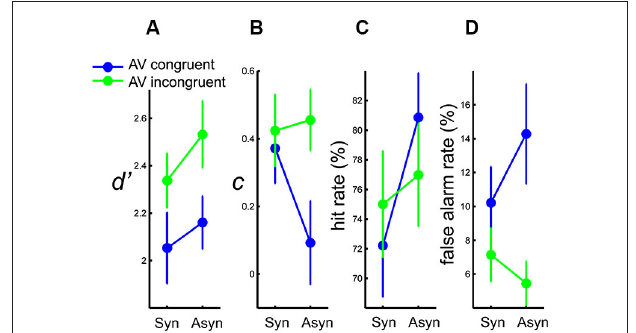
FIGURE 3 | Results of (A) mean d’ , (B) mean c , (C) mean hit rate, and (D) mean false alarm rate, as a function of AV synchrony, for each AV congruency condition . Error bars represent standard error of the